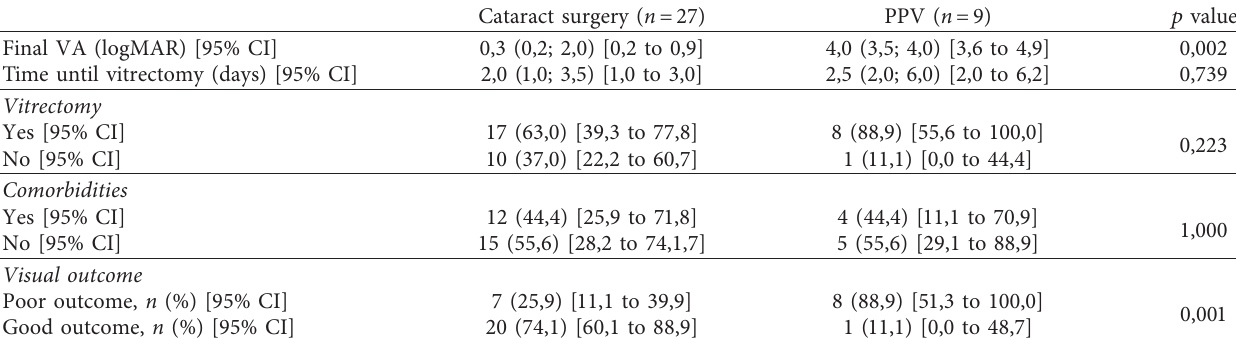
Values are displayed as median (IQR) for continuous variables and number (%) for categorical variables. Comparisons were made with nonparametric Kruskal–Wallis test following Dunn-Bonferroni post hoc tests. The level of statistical significance was set at p < . 05. Poor outcome was classified as VA worse than or equal than counting fingers (CF) and good outcome classified as VA better than CF. PPV � pars plana vitrectomy; VA � visual acuity; log- MAR � logarithm of the minimal angle of